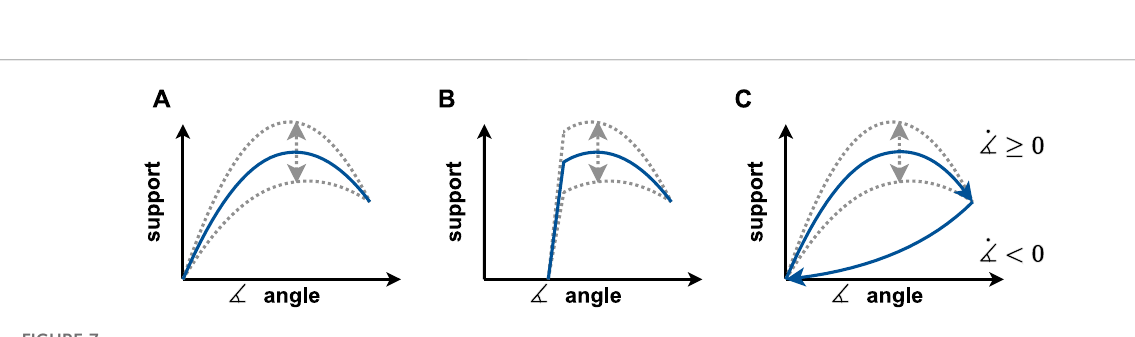
Frontiers in Robotics and